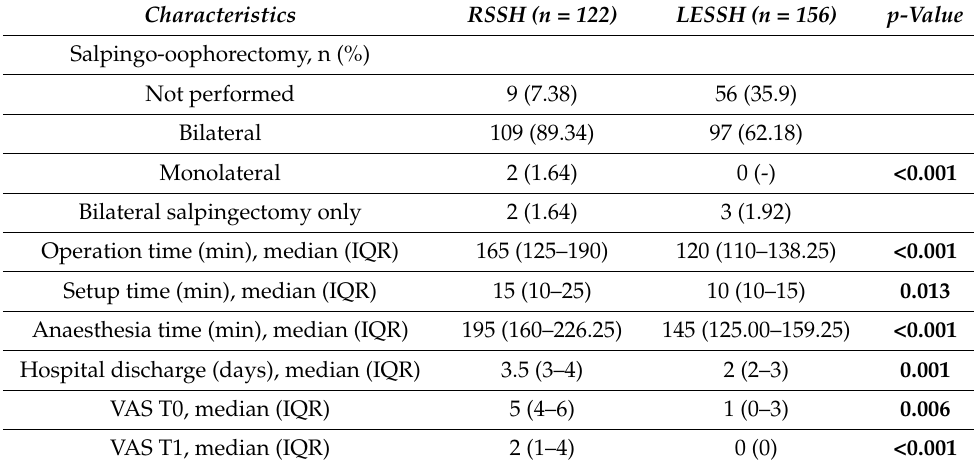
Table 2. Surgical parameters in RSSH and LESSH